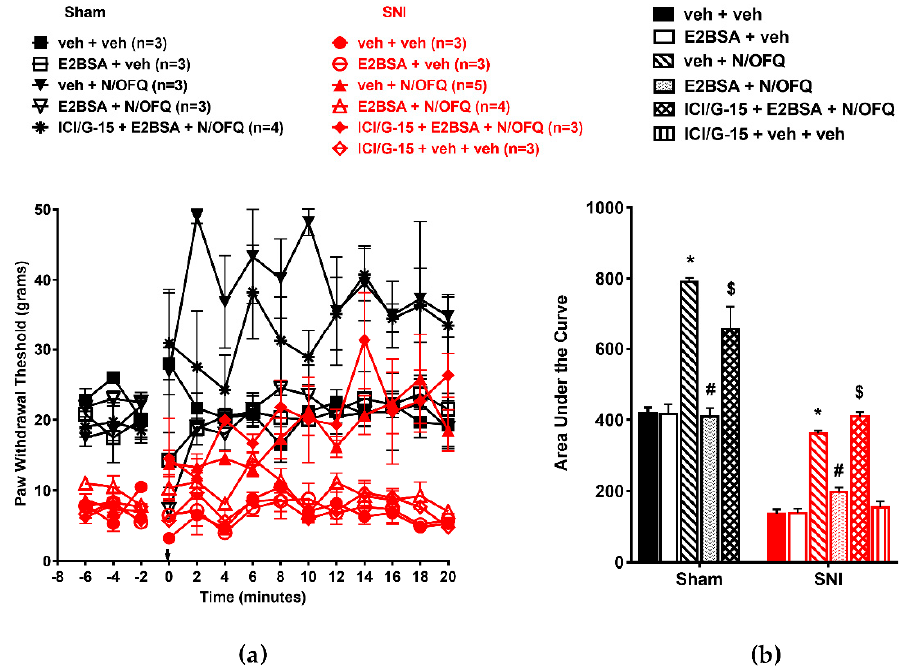
Figure 2. Intrathecally administered E 2 BSA rapidly attenuated NOP-mediated antihypersensitivity in male rats. ( a ) SNI significantly reduced PWTs compared to the sham group. N/OFQ (10 nM) increased